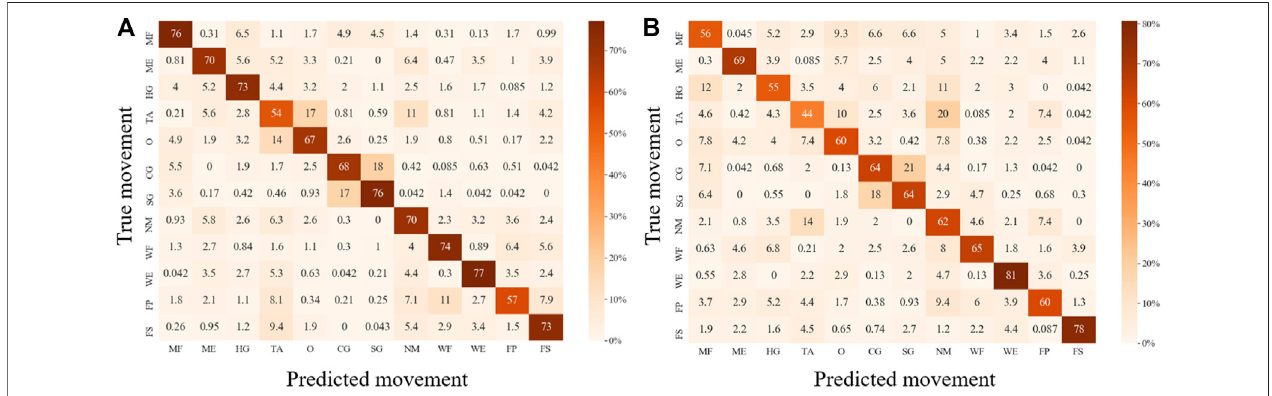
FIGURE 7 | Confusion matrixes for movement classi fi cation based on different sensor con fi gurations. (A) , Confusion matrix for EMG-based movement classi fi cation. (B) , Confusion matrix for FMG-based movement classi fi cation.